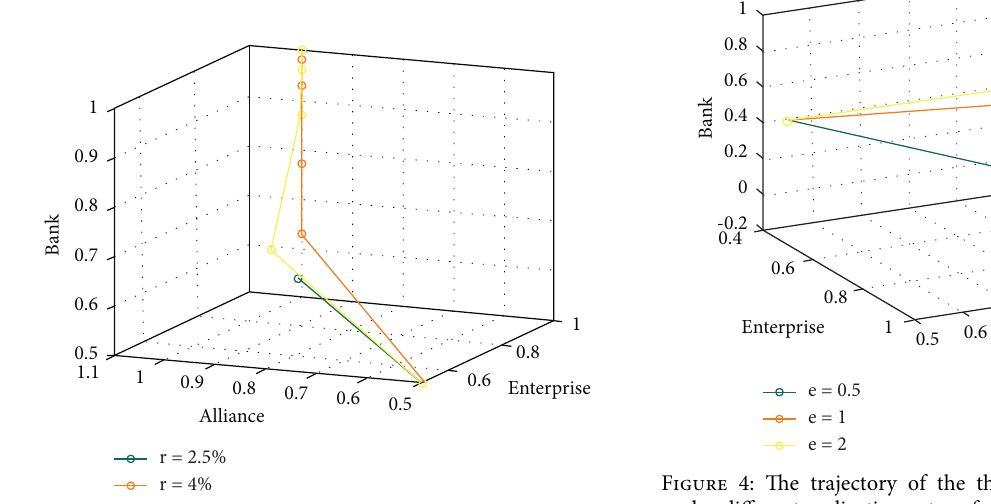
Figure 1: Three-party evolutionary game trajectory under different credit levels.